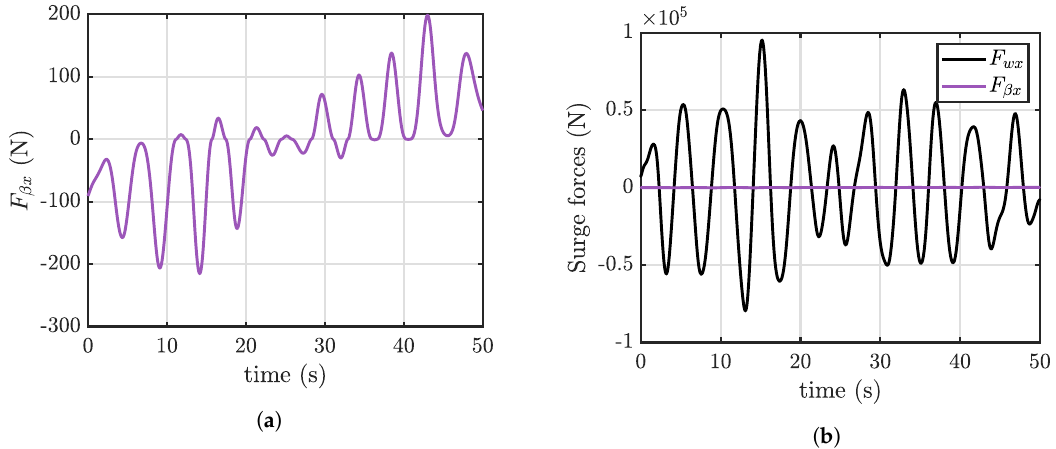
Figure 6. Viscous damping in surge direction magnitude ( a ) and comparison with WEF ( b ) (Wave Id 2). ( a ) Viscous damping in surge direction; ( b ) WEF and viscous damping in surge direction